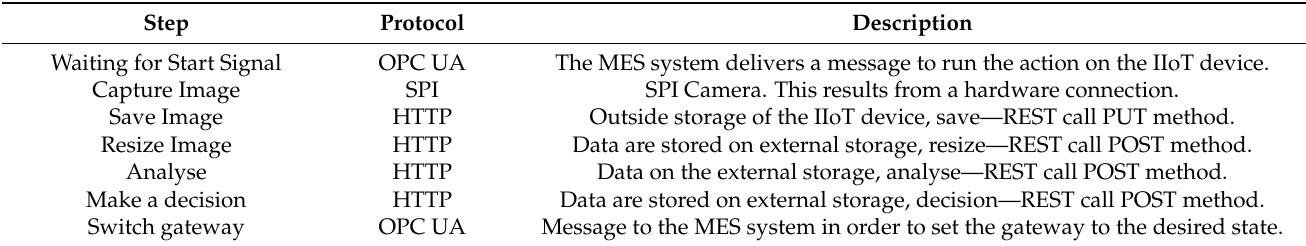
Table 5. Description of protocols for individual